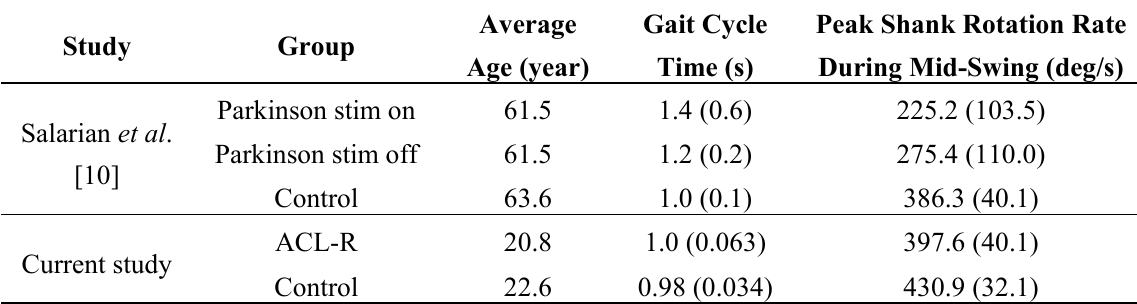
Table 5. Peak shank rotation rate during mid-swing comparison. Mean values are presented with standard deviations in